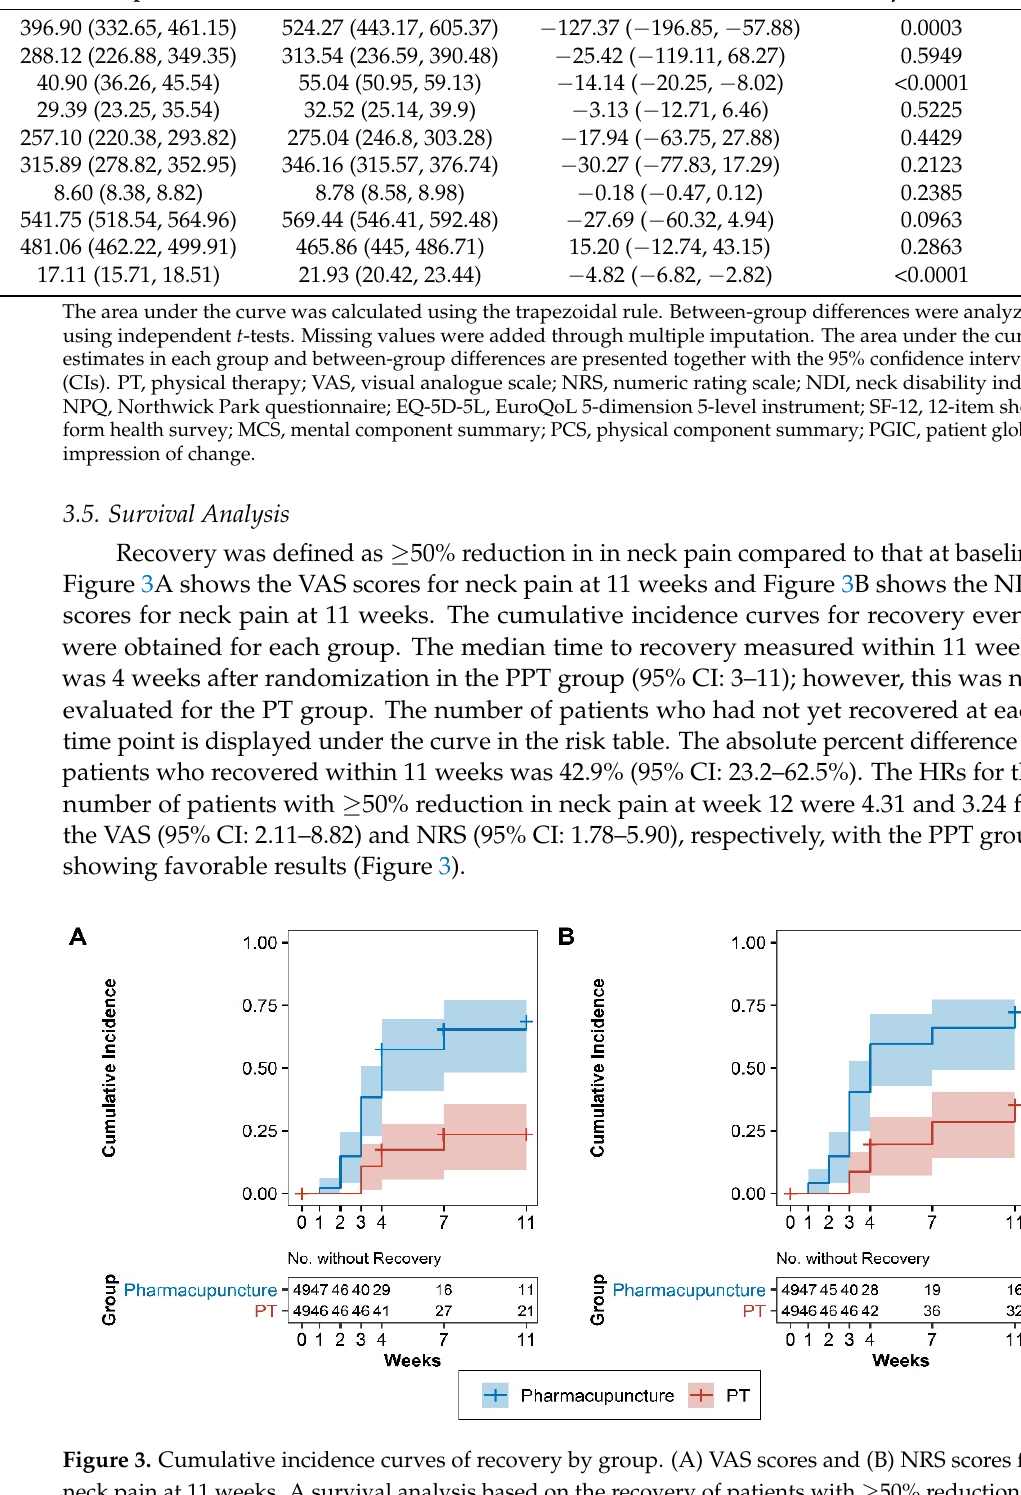
Figure 3. Cumulative incidence curves of recovery by group. (A) VAS scores and (B) NRS scores for neck pain at 11 weeks. A survival analysis based on the recovery of patients with ≥ 50% reduction in neck pain revealed that the pharmacopuncture group had a faster recovery rate than the PT group over the course of 11 weeks ( p < 0.001, log-rank test). The HRs for the number of patients with ≥ 50% reduction in neck pain at week 12 were 4.31 and 3.24 for the VAS (95% CI: 2.11–8.82) and NRS (95% CI: 1.78–5.90), respectively, with the pharmacopuncture group showing favorable results. VAS, visual analogue scale; NRS, numeric rating scale; PT, physical therapy; HR, hazard ratio; CI, confidence